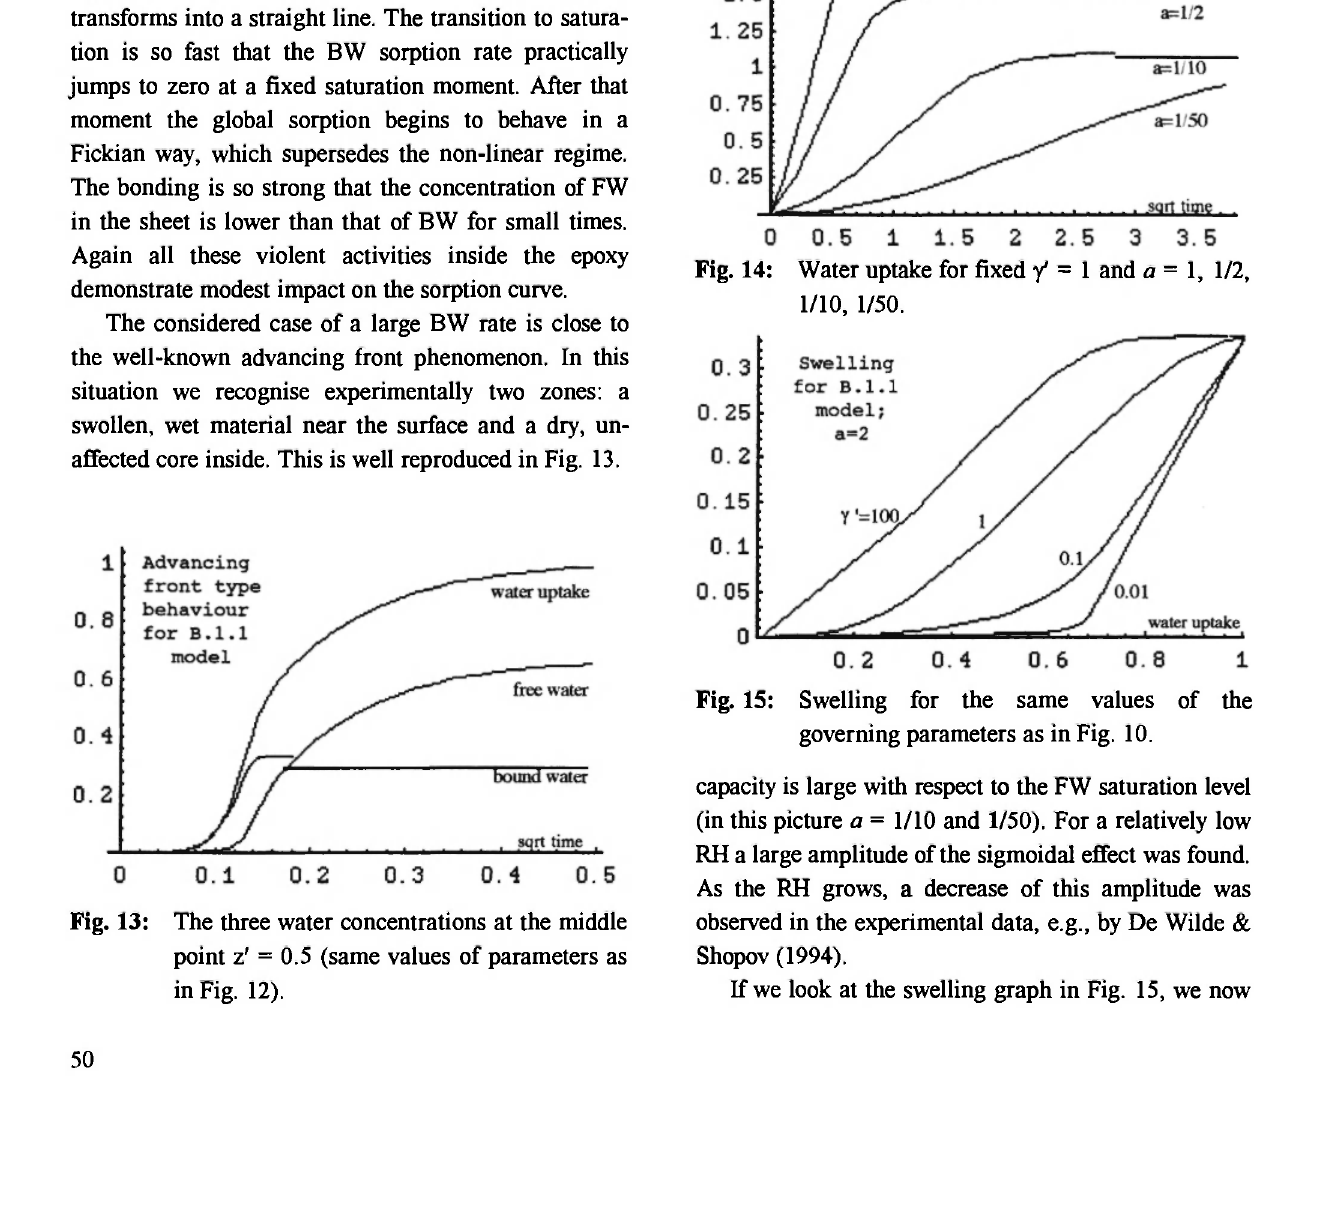
Fig. 12: Three forms of water (BW, FW and the total one) for B.2.1. model, a = 2, γ' = 1000.